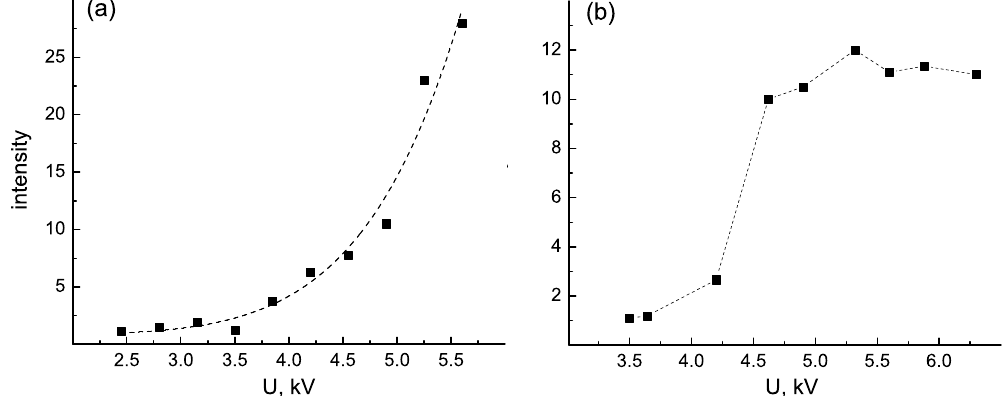
Figure 6. Intensity of OH-peak at λ = 309 nm in helium for different applied voltages with the grounded substrate ( a ) and the ratio of intensities of OH peaks with the grounded substrate and without it ( b ), v = 3 L/min.